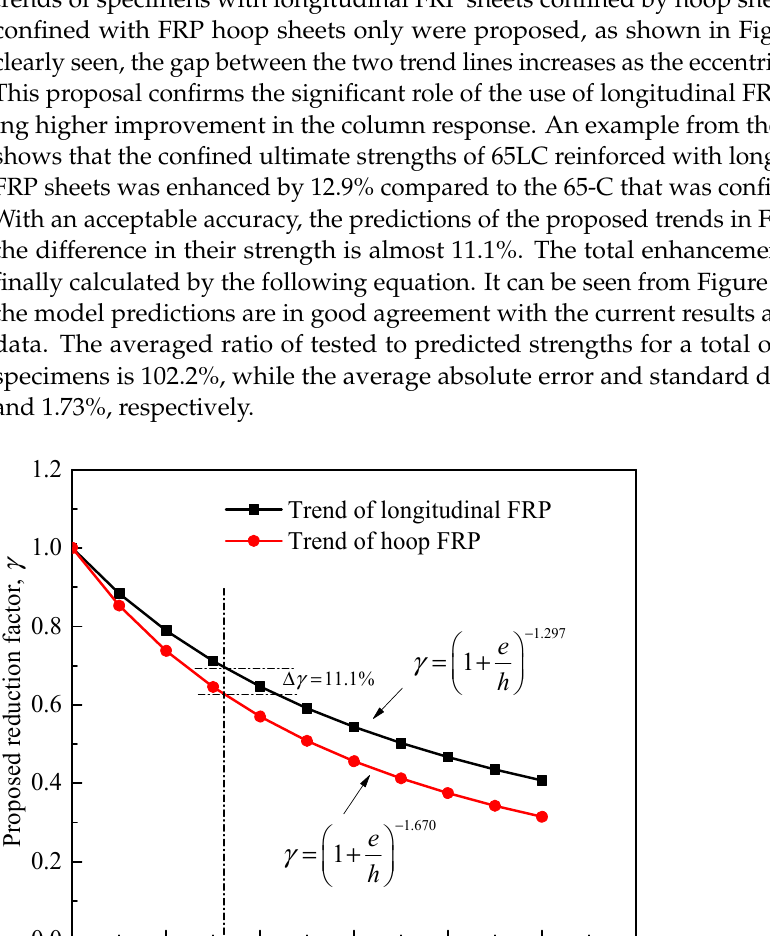
Figure 18. Comparison between experimental and predicted ultimate load ratios for FRP-confined RC columns.